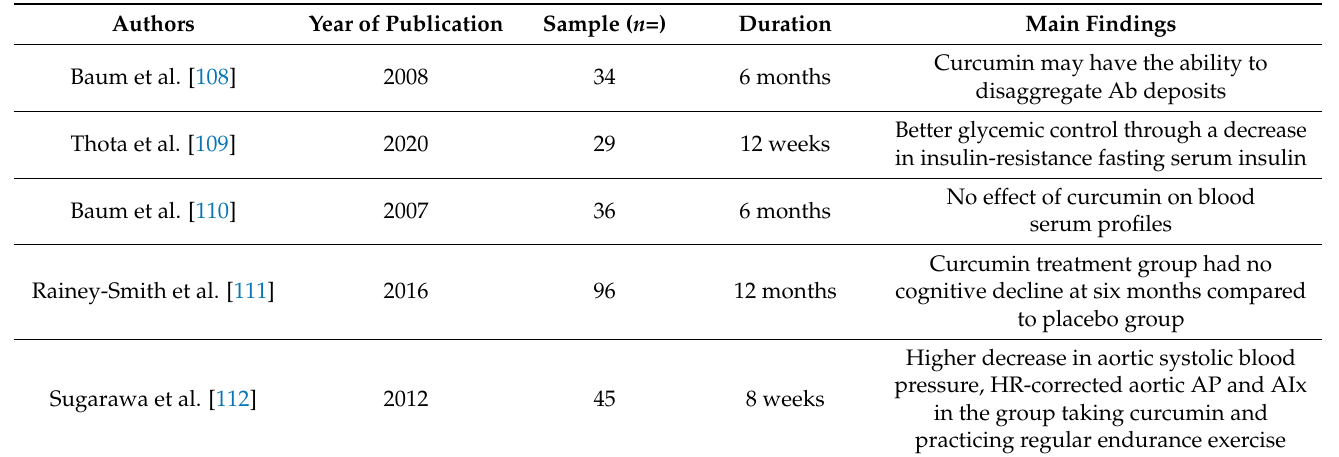
Table 1. Table reviewing human clinical trials using